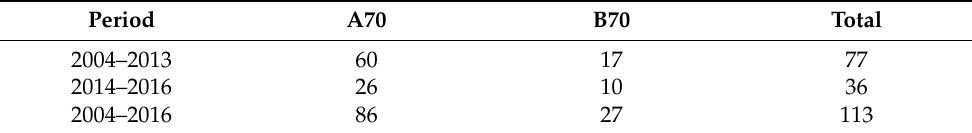
Figure 3. Comparison of ( a ) mean absolute errors (shading) and biases (solid lines) for intensity predictions of A70 (TCs with LMI greater than 70 kt) and B70 (TCs with LMI less than 70 kt) at each lead time for the 2013–2014 TWNP TCs. ( b ) Comparison of the relative frequencies of intensity change in 48 h in the classified groups (red: A70; blue: B70). The shaded areas show the raw data binned into 5 kt bins. The thick lines are the smoothed relative frequencies with a window width of 15 kt. The dashed lines indicate the means of each group. The mean values with ± σ are represented in colored text. Table 2. Number of A70 and B70 tropical cyclones in 2004–2013, 2014–2016, and